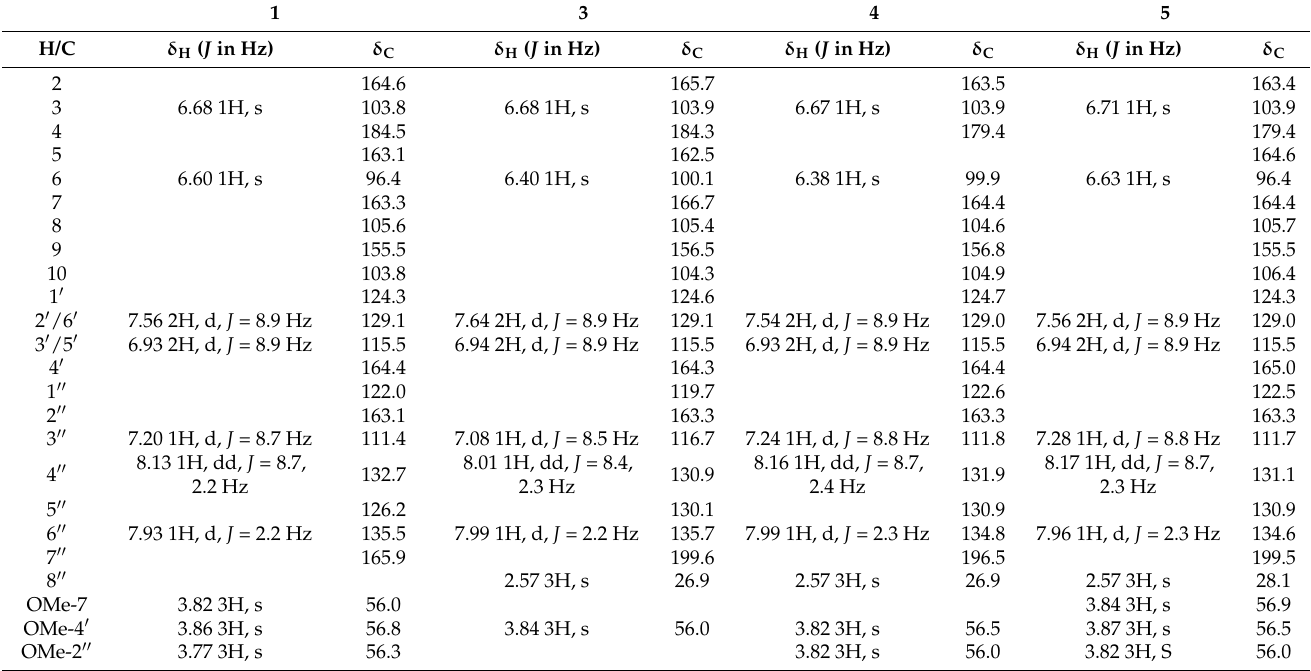
Table 3. 1 H NMR and 13 C NMR data of compounds 1 , 3 – 5